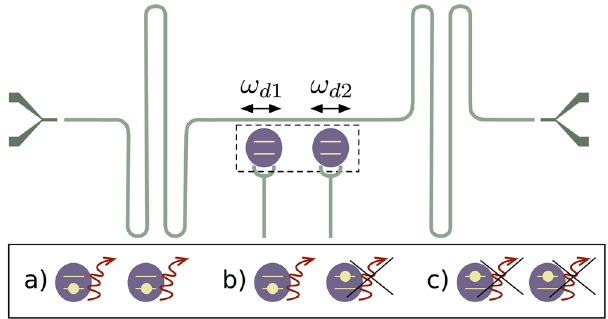
Figure 1. Two superconducting qubits strongly coupled to a single resonator mode and driven with frequencies ω ω d 1 and d 2 simulating harmonic relativistic speeds. The resonator of length L c is initially in the vacuum while the qubits, which are located in the middle of the cavity x = 0, are initially ( a ) both in the ground state, ( b ) one in the excited state and the other in the ground state, ( c ) both in the excited state. The red wavy arrows indicate emission or absence of emission of photons from the qubits, showing a subradiant behaviour.